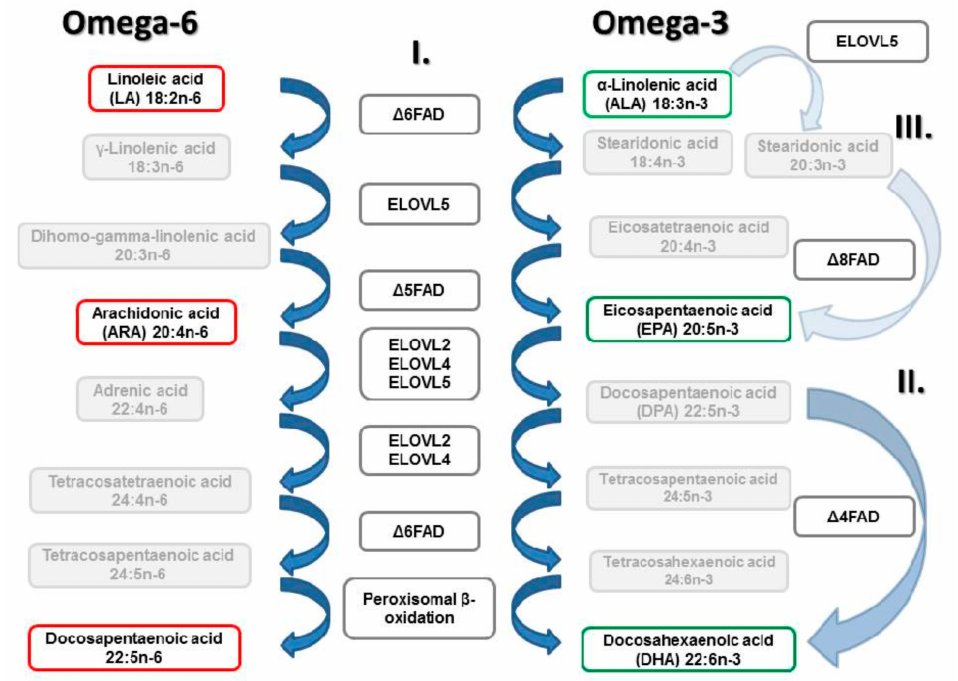
Figure 1. Biosynthetic pathways of long-chain ( ≥ C 20 ) polyunsaturated fatty acids (LC-PUFAs) of ω 3 and ω 6 families from dietary essential α -linolenic (ALA, 18:3n-3) and linoleic (LA, 18:2n-6) acids, respectively, by elongation and desaturation reactions. Adapted from (Carmona-Antoñanzas et al., 2011; Monroig et al., 2011; Sprecher, 2000; Voss et al., 1991); modified after (Trattner, 2009; Vestergeren, 2014; Yan,